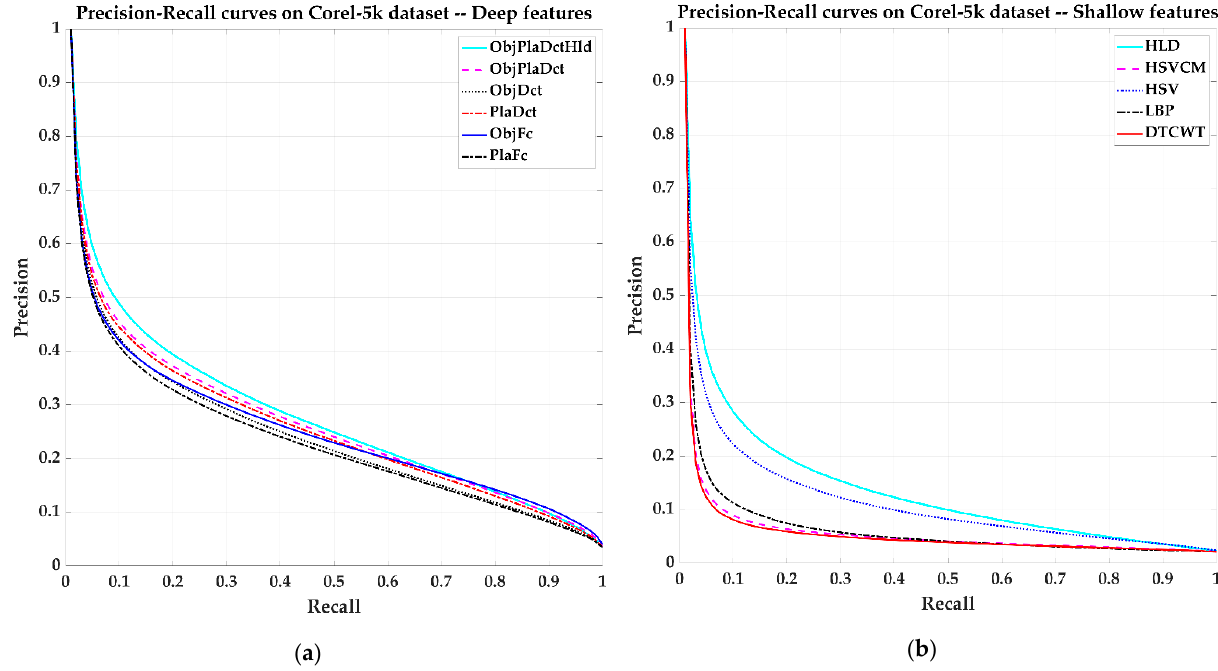
Figure 10. Precision-Recall curves on the Corel-5k dataset. ( a ) The methods based on deep features; ( b ) The methods based on shallow features.